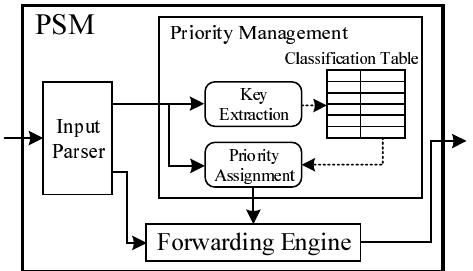
Figure 4. The design of Packet Schedule